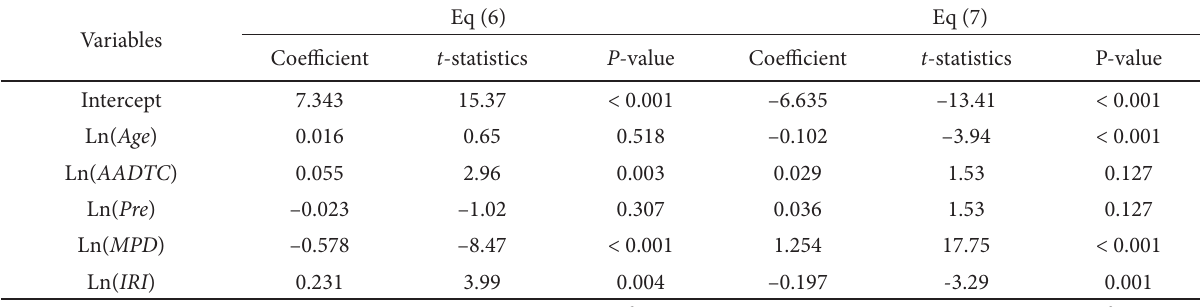
Table 1. Parameter estimates of Thickness and